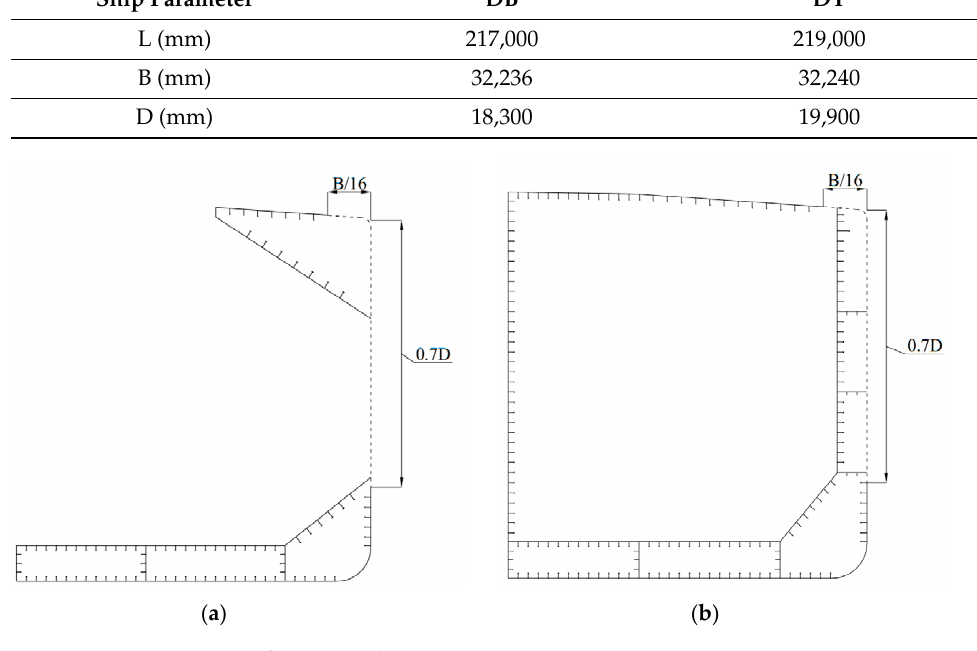
Figure 8. Cross sections of ( a ) DB and ( b ) DT.